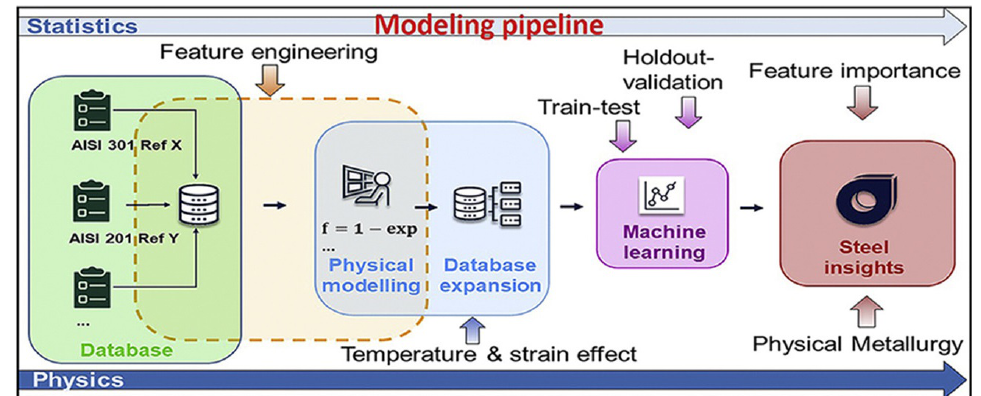
Figure 7. Mu et al. [63] have developed a combinatorial model pipeline to simulate strain induced martensitic transformation in austenitic steels. The use of feature engineering and the ensemble methods, and the methodology to integrate the physical modeling with the data-driven method, are some of the major highlights of the combinatorial